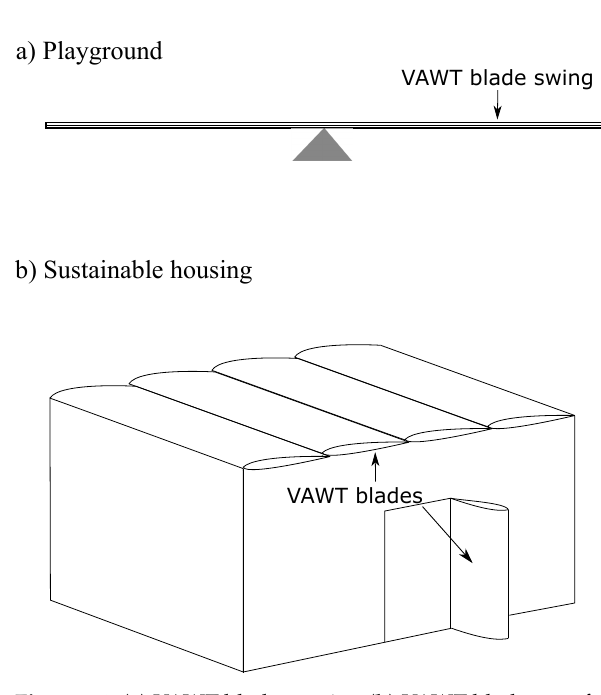
Figure 14. ( a ) VAWT blade—swing ( b ) VAWT blade—roof and door